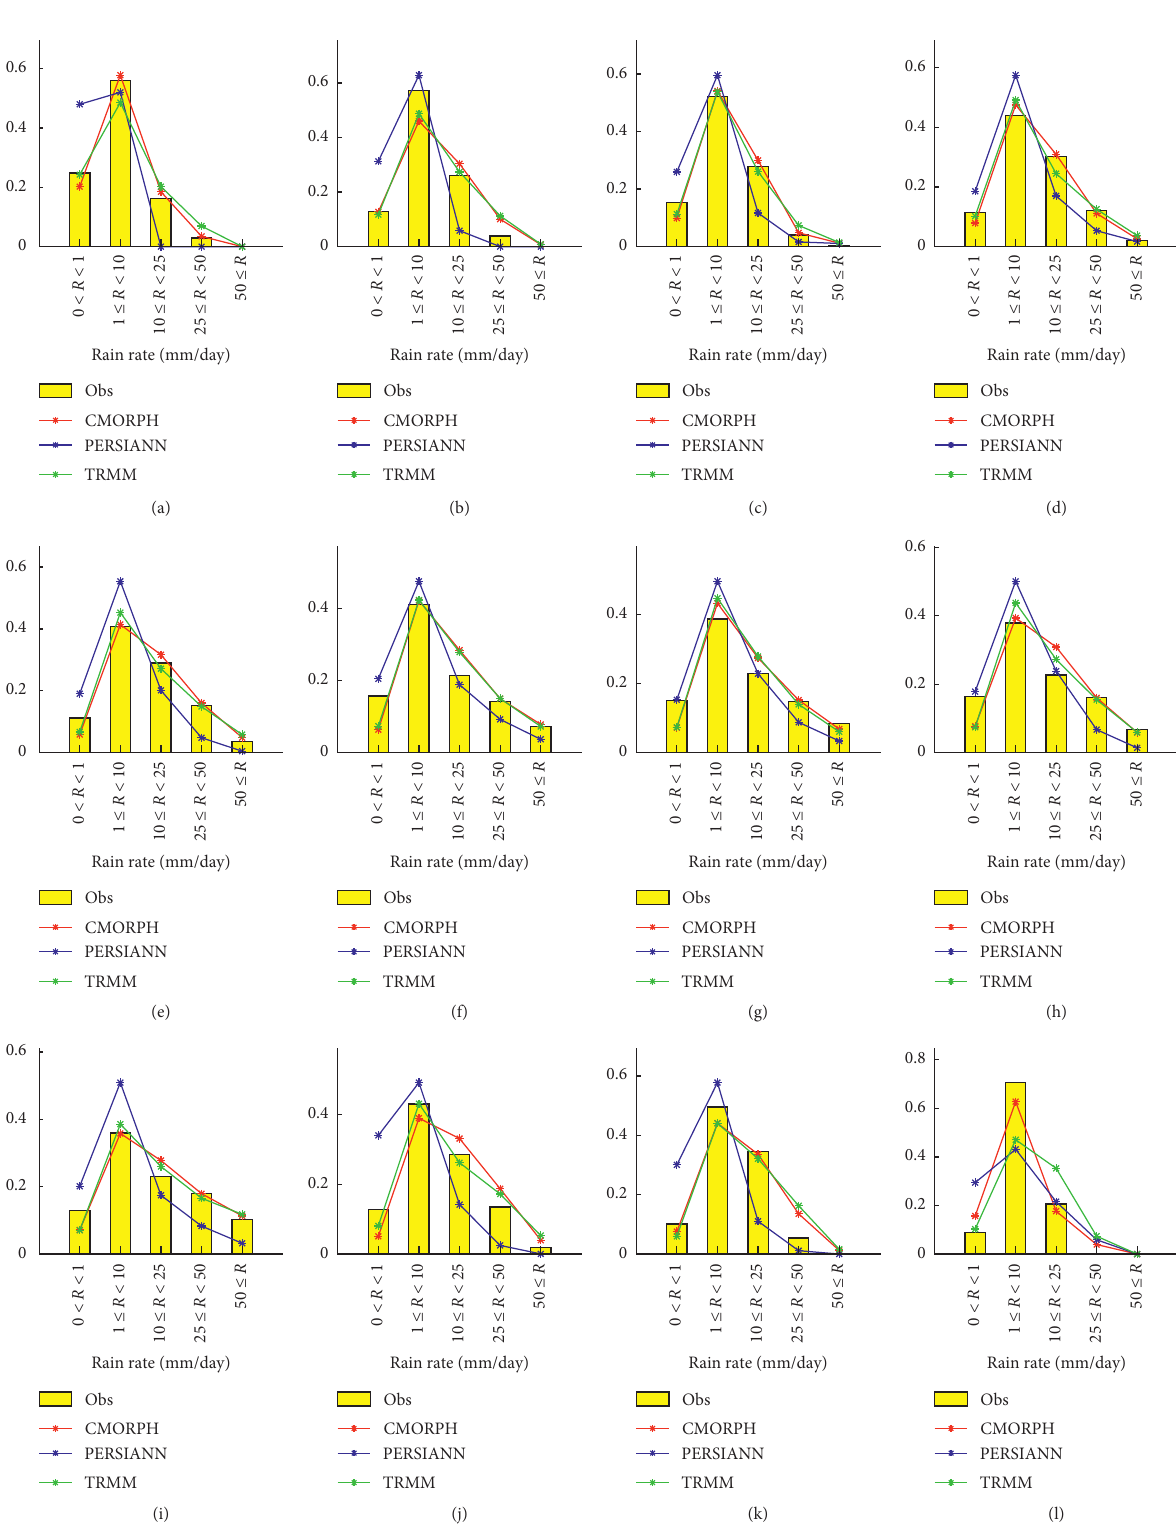
Figure 19: The frequency of occurrence of drizzle (0 < R < 1), light rain (1 ≤ R < 10), moderate rain (10 ≤ R < 25), heavy rain (25 ≤ R < 50), and above (50 ≤ R ) for each month. In each subplot, the yellow bar denoted the gauge observation, the red line with an asterisk denoted the CMORPH, the blue line with an asterisk denoted the PERSIANN, and the green line with an asterisk denoted the